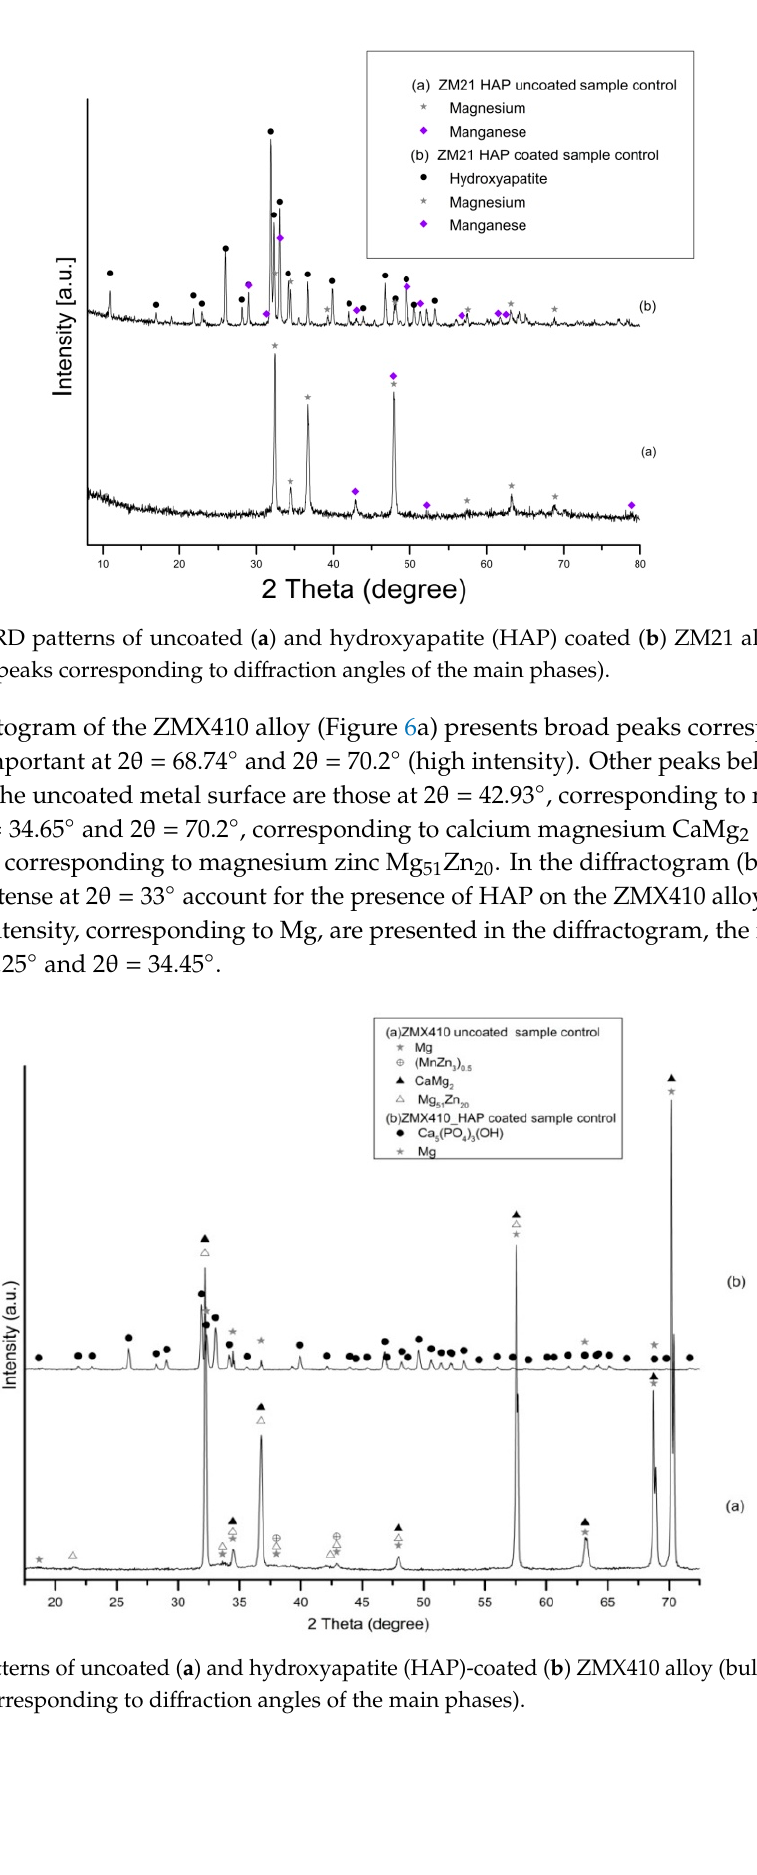
Figure 6. patterns of uncoated ( a ) and hydroxyapatite (HAP)-coated ( b ) ZMX410 alloy (bullets indicate the peaks corresponding to diffraction angles of the main phases) . 3.3. FTIR Results According the results of the FTIR spectroscopy, the deposited coatings are composed of HAP (Figure 7). Indeed, the main peaks assignable to HAP are: ~567 and ~600 cm − 1 corresponding to the